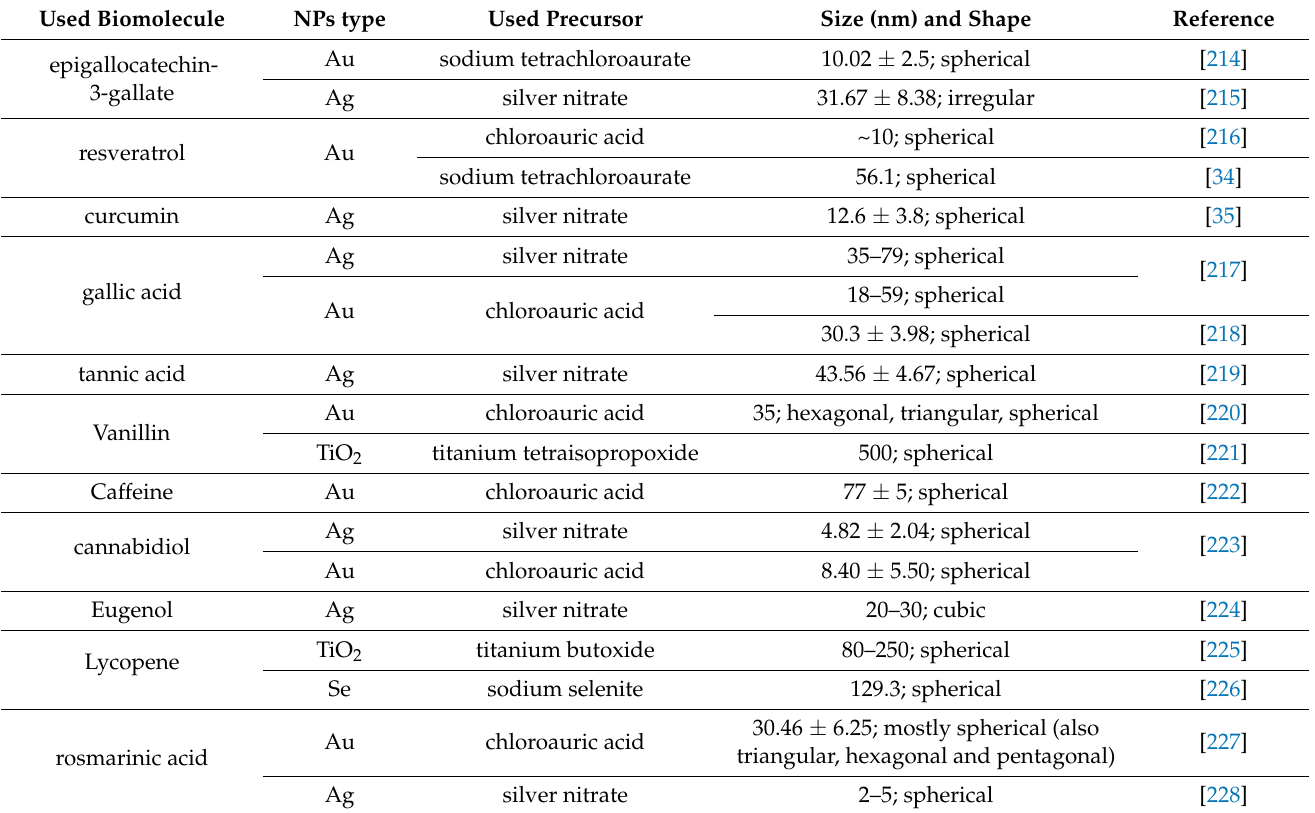
Table 3. Studies exploring metallic/metallic oxide NP synthesis through one-molecule green